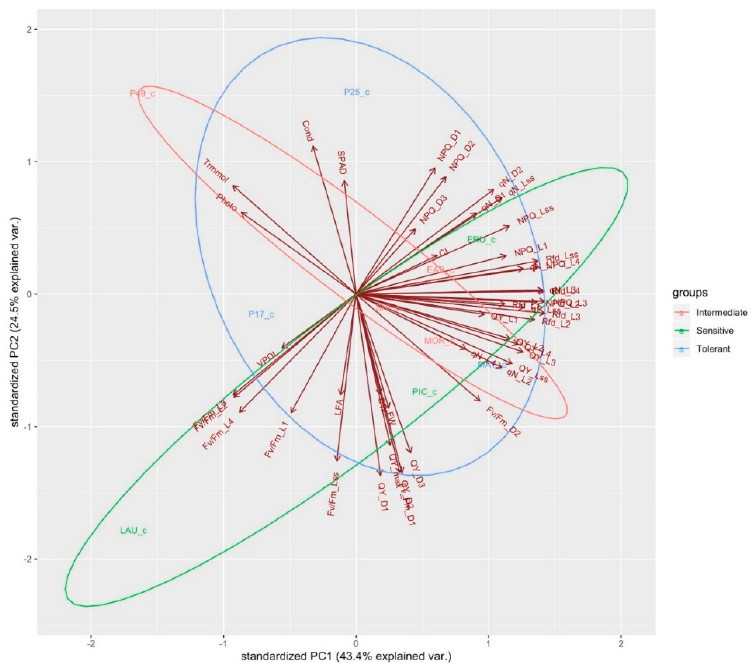
Figure 6. Principal component loading plot and scores of PCA on morphological, physiological, and chlorophyll fluorescence parameters of sensitive, intermediate, and tolerant genotypes grown under control conditions, grouped by colored ellipses.